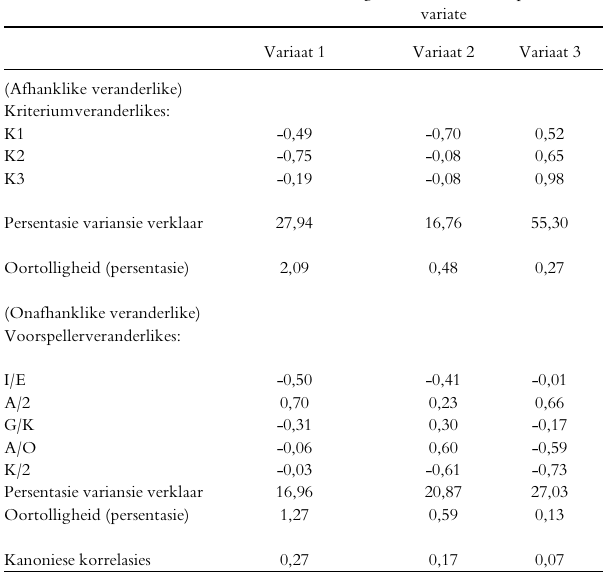
TABEL 9 KANONIESE KORRELASIESVAN DIE KRITERIAASAFHANKLIKEVERAN- DERLIKESENDIESA92,VORM BTWEEDEORDEFAKTOREAS ONAFHANK- LIKEVERANDERLIKES Faktorladings van veranderlikes op kanoniese